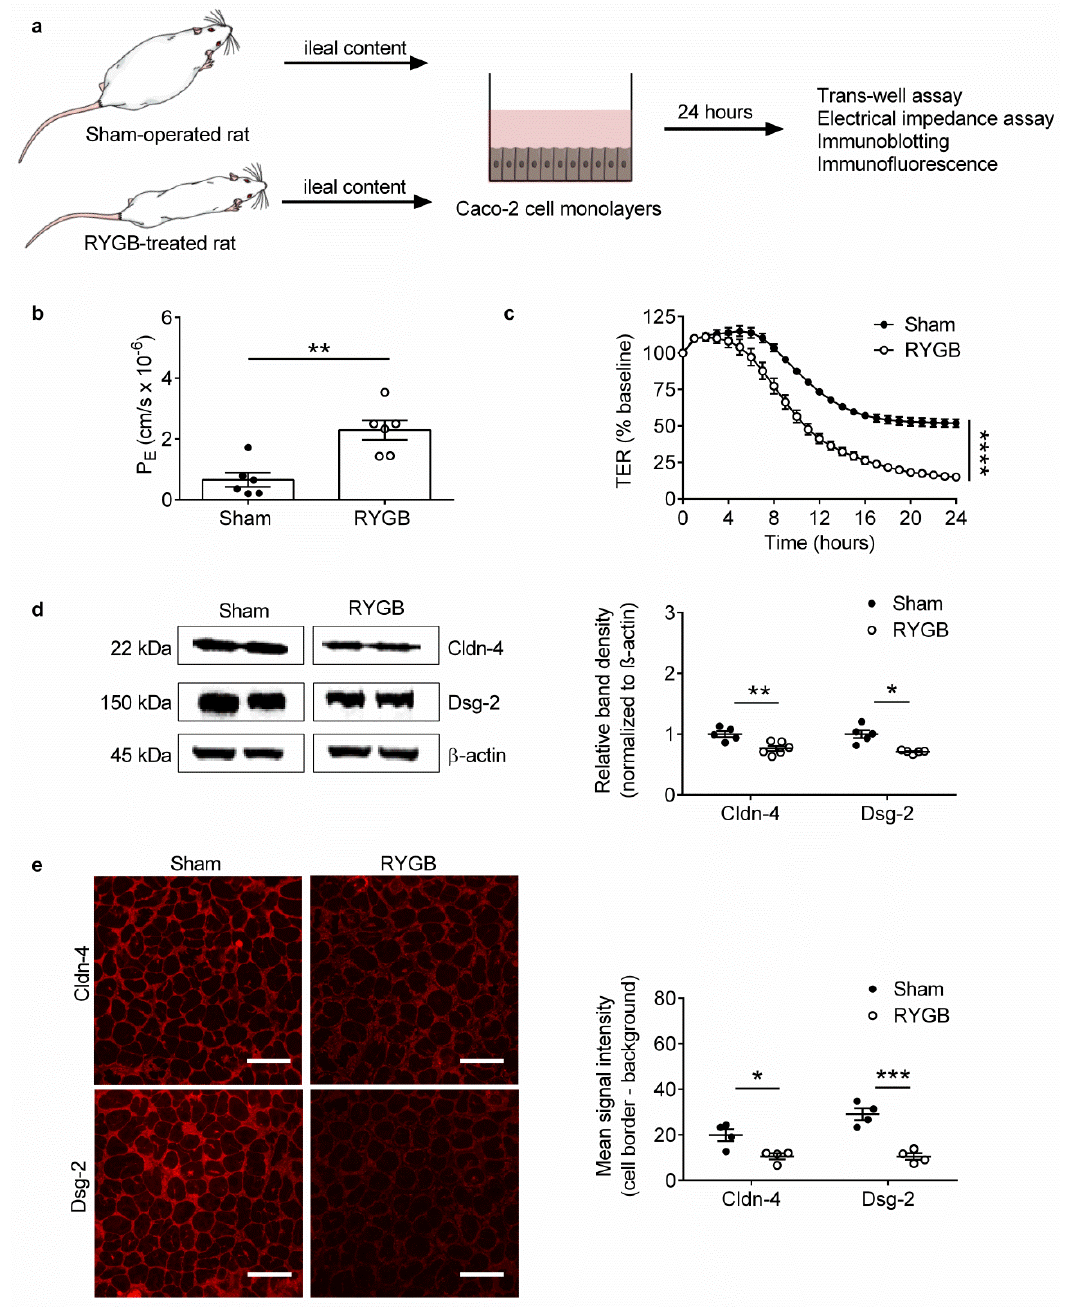
Figure 2. Ileal Content of RYGB-Treated Rats Contains Soluble Metabolites Which Disrupt Barrier Function and Structure in Caco-2 Cells. ( a ) Schematic diagram illustrating experiments performed on Caco-2 cells. ( b ) Permeability coefficients (P E ) obtained from trans-well assays performed on Caco-2 cells treated for 24 h with ileal content from RYGB-treated and sham-operated rats. n = 6 cultures/group from 1 independent experiment. ( c ) Trans-epithelial electrical resistance (TER) values obtained from low-frequency electrical impedance assays performed on Caco-2 cells treated for 24 h with ileal content from RYGB-treated and sham-operated rats. n = 10–12 cultures/group from 2 independent experiments. ( d ) Immunoblot analysis of claudin-4 (Cldn-4) and desmoglein-2 (Dsg-2) protein expression in Caco-2 cells treated for 24 h with ileal content from RYGB-treated and sham-operated rats. n = 5–6 cultures/group from 1 independent experiment. ( e ) Immunofluorescent analysis of Cldn-4 and Dsg-2 protein levels at the cell border of Caco-2 cells treated for 24 h with ileal content RYGB-treated and sham-operated rats. Scale bar: 25 µm. Data in ( b – e ) are presented as mean ± SEM. Statistical significance was determined by two-tailed, unpaired t -test with Welch’s correction in ( b , d , e ) and two-way ANOVA (main effect of treatment) in ( c ). **** p < 0.0001, *** p < 0.001, ** p < 0.01, and * p < 0.05.